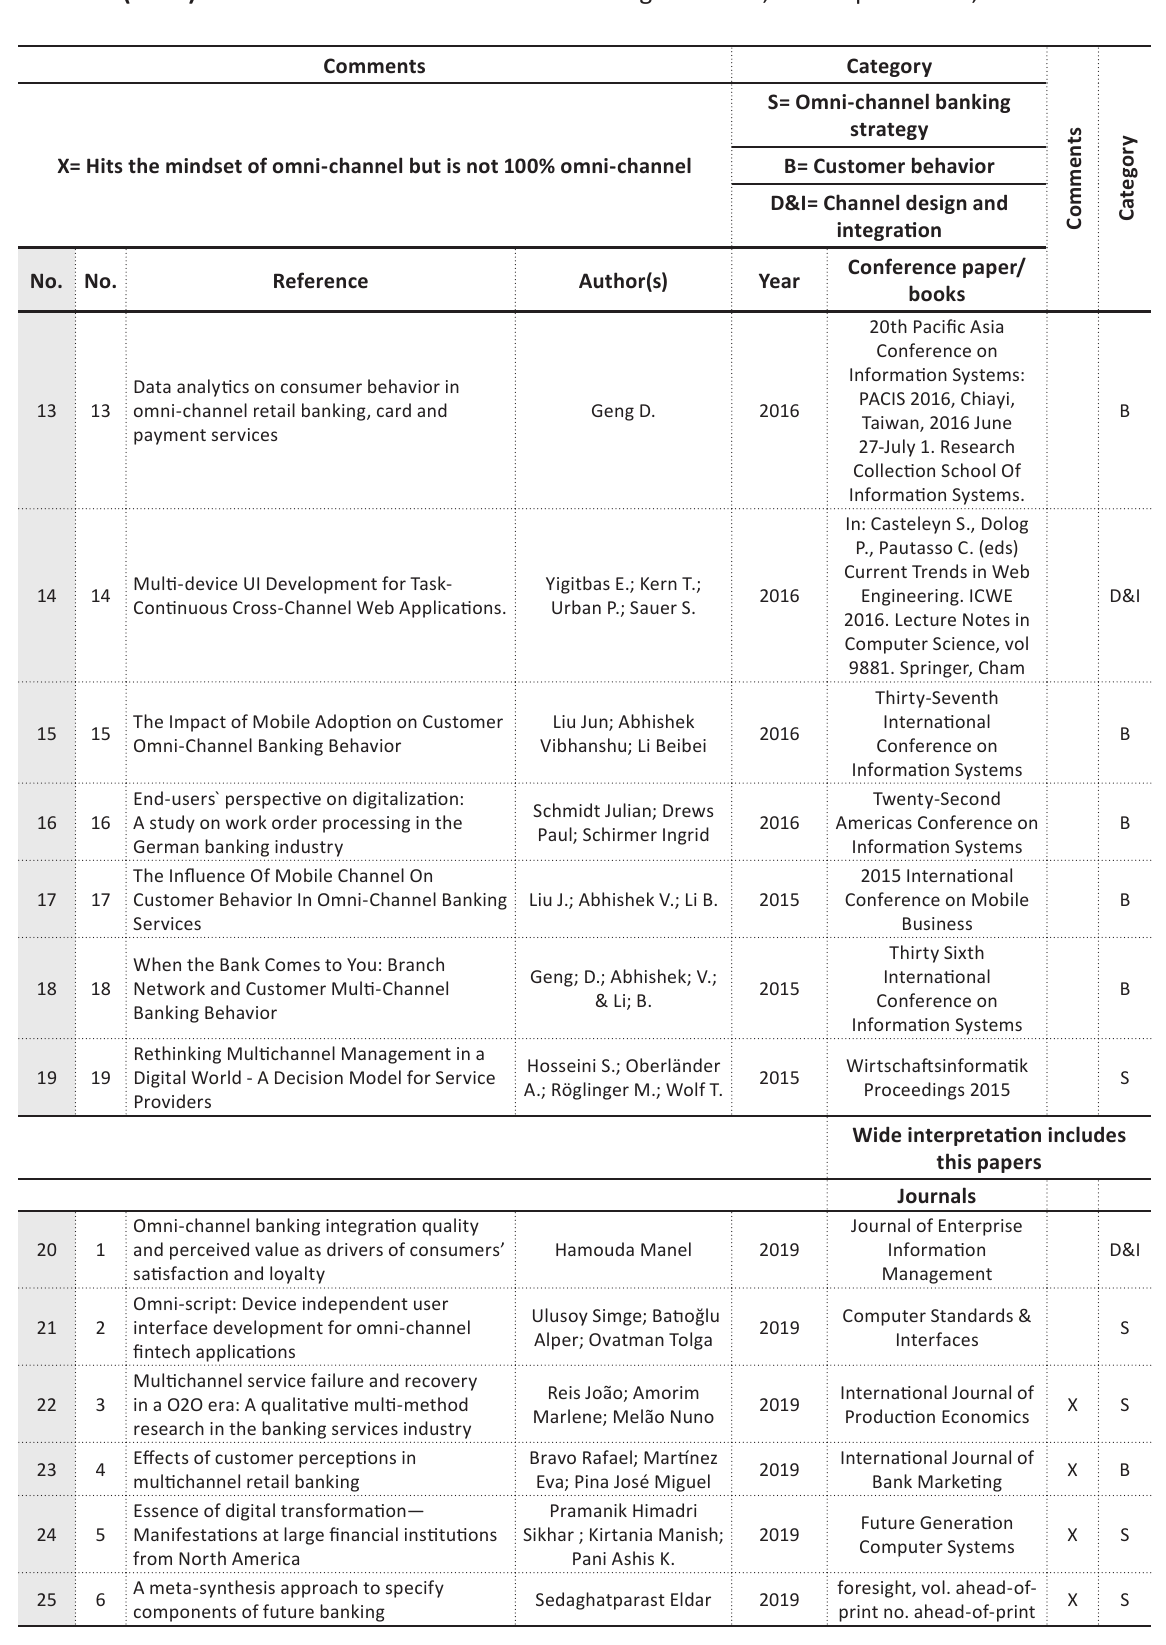
Table A1 (cont.). Omni-channel in the context of banking literature, search phases 3.1,